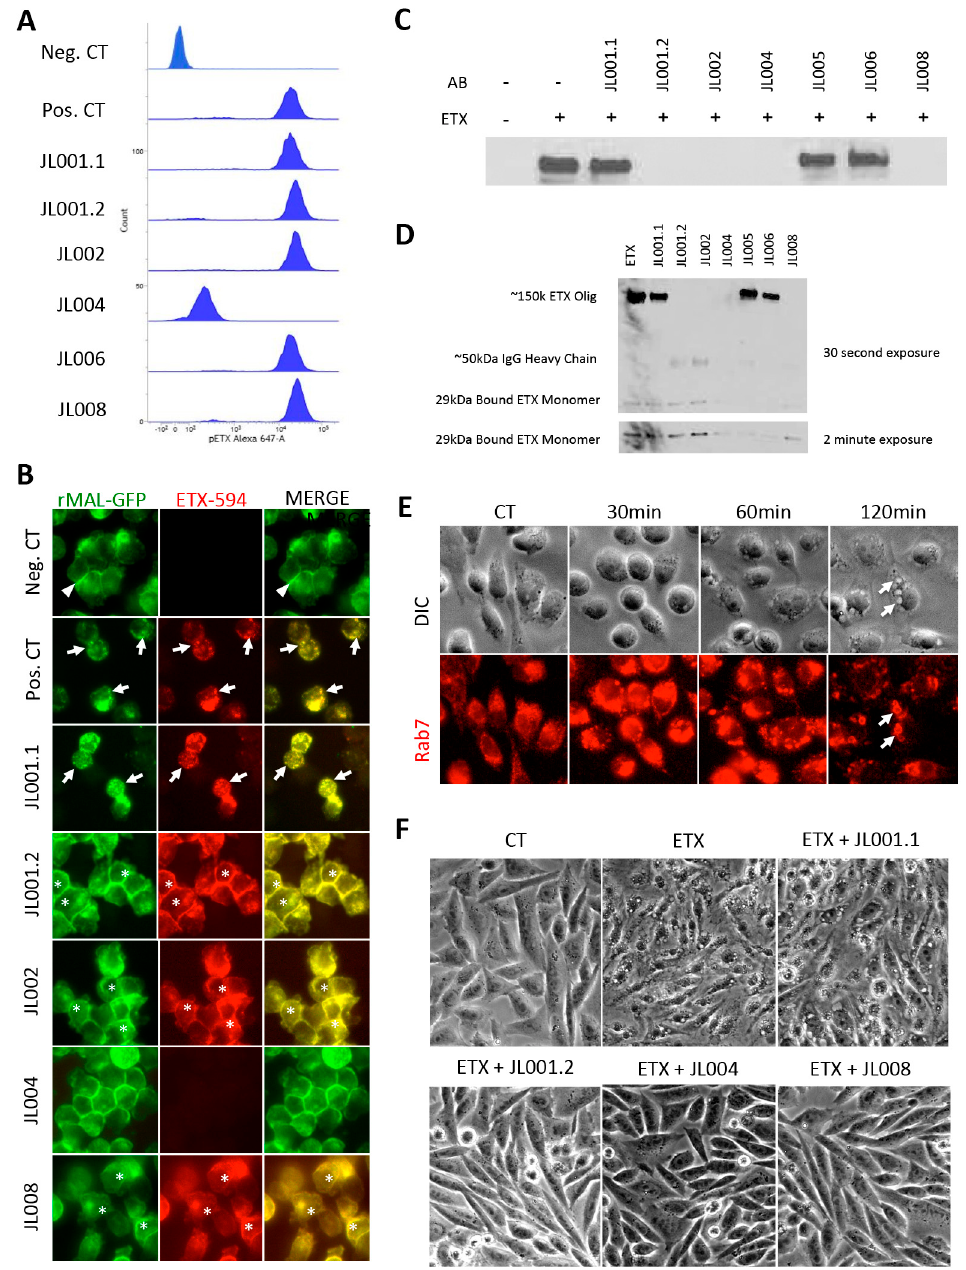
Figure 8. Anti-ETX antibody inhibition of ETX binding and oligomerization in rMAL-CHO cells. ( A ) Alexa-647 conjugated epsilon protoxin (pETX-647) was pre-incubated with indicated anti-ETX antibodies prior to treatment of rMAL-CHO cells. Medium containing pETX-647 alone was used as a positive control for pETX binding (Pos. CT). Medium without pETX or antibodies was used as a negative control (Neg CT). Only antibody JL004 inhibited pETX-647 binding to rMAL-CHO cells. ( B ) Alexa-594 conjugated epsilon toxin (ETX-594) was pre-incubated with indicated anti-ETX antibodies prior to treatment of rMAL-CHO cells. Media containing ETX-594 alone was used as a positive control for ETX binding (Pos. CT). Media without ETX-594 or antibodies was used as a negative control (Neg CT). In the negative control cells, note that the majority of rMAL-GFP is located at the plasma membrane, especially in areas of cell-to-cell contact (white triangles). In comparison, cells treated with ETX-594 alone (Pos. CT) or JL001.1 show evidence of rMAL-GFP internalization, visualized as punctate dots (white arrows). Internalized ETX-594 also colocalizes with rMAL-GFP. No ETX-594 binding was observed in the presence of JL004. JL001.2, JL002, and JL008 inhibited ETX internalization, but